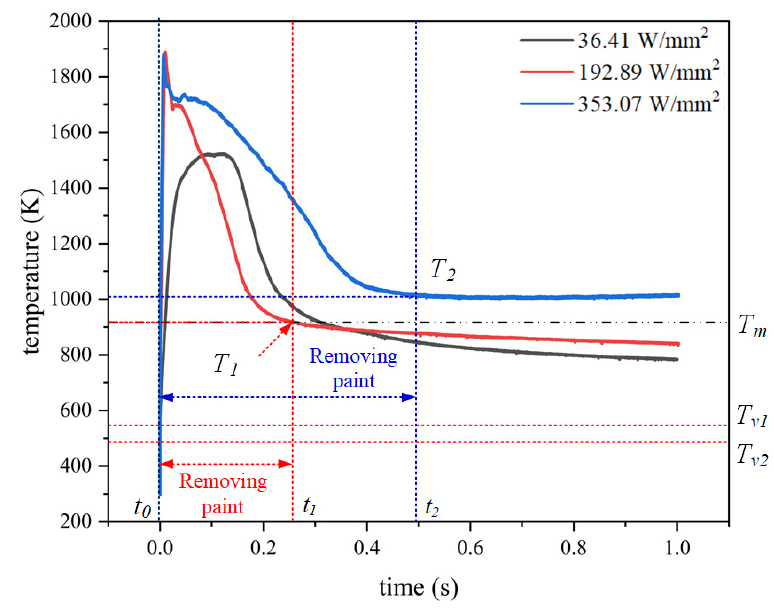
Figure 5. Temperature change during the removal of epoxy primer and epoxy varnish. When the power density was 192.89 W/mm 2 , the vaporization points T v2 and T v1 of epoxy varnish and epoxy primer were reached at t 0 = 0.2 × 10 − 5 s. The paint removal started and the temperature was 566.84 K. The heating interval was 0–0.007 s. At this time, due to the heat conduction, the two coatings began to phase change. It entered the temperature platform at 0.02 s, and the temperature began to decrease slowly with the removal of paint. t 0 to t 1 is the paint removal interval. With the paint removal completed, the laser directly acts on the aluminum alloy sub- strate, where T 1 (0.27 s, 907.78 K) the temperature dropped to the melting point of the aluminum alloy. Since the paint layer was removed, the temperature changed from a downward trend to a flat one. In this time, the temperature curve is the temperature of laser irradiation of aluminum alloy. Since the temperature is lower than the melting point of aluminum alloy, there is no matrix damage. When the power density was 353.07 W/mm 2 , the temperature rapidly increased to the vaporization point of the two coatings ( t 0 ≤ 0.1 × 10 − 5 s), and the heating interval was 0–0.006 s. At 0.09 s, the phase-change coatings were removed and entered the temperature platform. The slow temperature drop at 0.09–0.49 s is caused by the excessive laser power. The range of t 0 to t 2 is paint removal and the temperature decreases rapidly with the de- crease of paint. When the temperature decreases to the lowest temperature T 2 (0.49 s, 1009.06 K), the paint is completely removed and the laser directly acts on the aluminum alloy. Excessive laser power directly affects the aluminum alloy substrate, resulting in aluminum alloy melting and temperature rise. For the two-layer coating system, when the laser power density was the same, the peak temperature of the No. 2 target was not as high as that of No. 1. This inconsistency may be due to the smooth and white surface of the epoxy varnish. The laser absorption capacity was worse than that of the No. 1 target, which will increase the optimal cleaning threshold. When the laser is applied, the upper paint film starts to be cleaned when the temperature reaches the vaporization point, while the lower paint absorbs heat, and the temperature also rises to the vaporization point. When the upper layer of paint is re- moved, the lower layer of paint will start to be removed immediately. Therefore, the paint removal process of No. 2 target material was faster than that of the No. 1 target material.